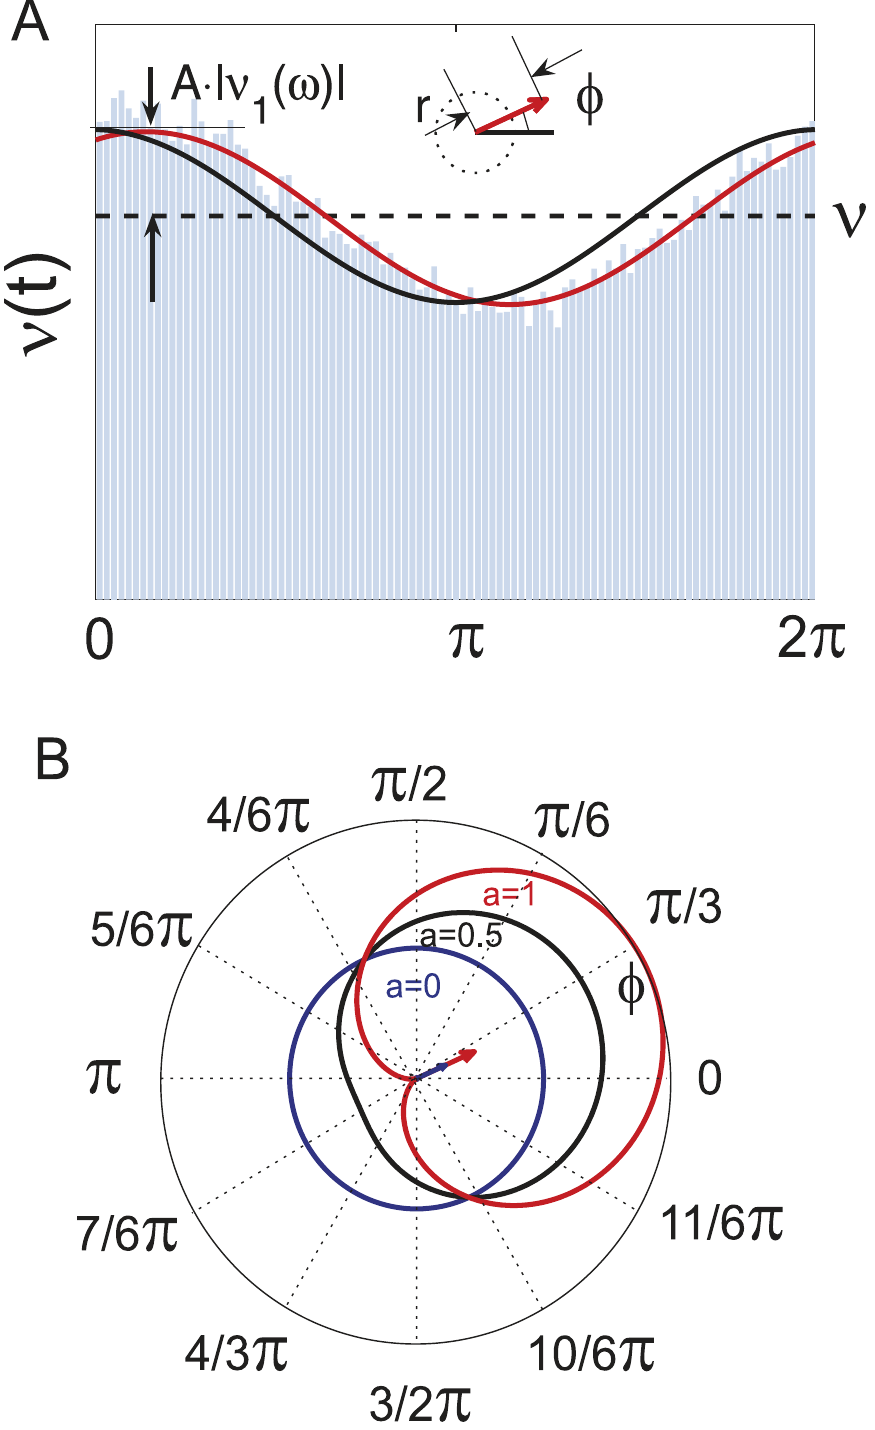
Figure 9. Demonstration of population firing rate modulation and phase locking. (A) Simulated population firing rate n ( t ) for mean current modulation for n ~ 5Hz , t s ~ 10ms , t M ~ 20ms and v ~ 2 p : 12 Hz , time bin 1 = (1200)s . This results in r ~ 0 : 1228 , w ~ 0 : 4251 and in the amplitude of the firing rate modulation of A j n 1 ( v ) j ~ 0 : 226 n ~ 2 r n . Solid lines denote the envelop of n ( t ) (red) and the current modulation (black). Black and red arrows indicate the phase relation between the input current and the evoked firing rate response. (B) Theoretical distribution of phase lags w for varying modulation depth a ~ A j n 1 ( v ) j = n , for illustration we chose w ~ 0 : 4251 (from (A)). The solid curves are the distribution envelop for a ~ 1 (red), a ~ 0 : 5 (black), a ~ 0 (blue). The arrows indicate the corresponding mean phase w .